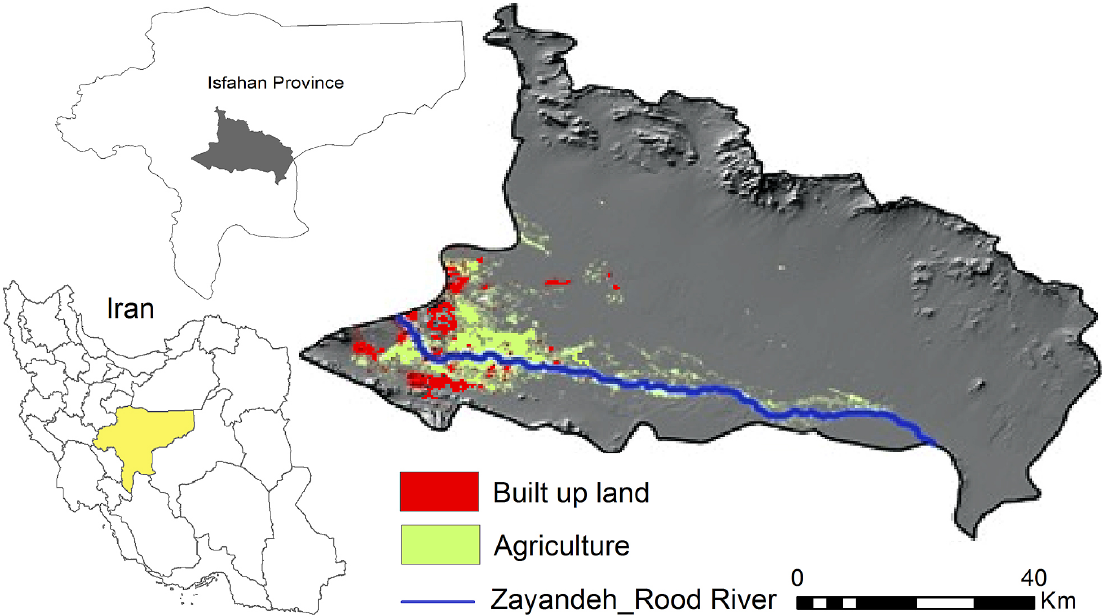
Fig. 1. The layout of the Segzi Hydrological Unit in Isfahan Province, central